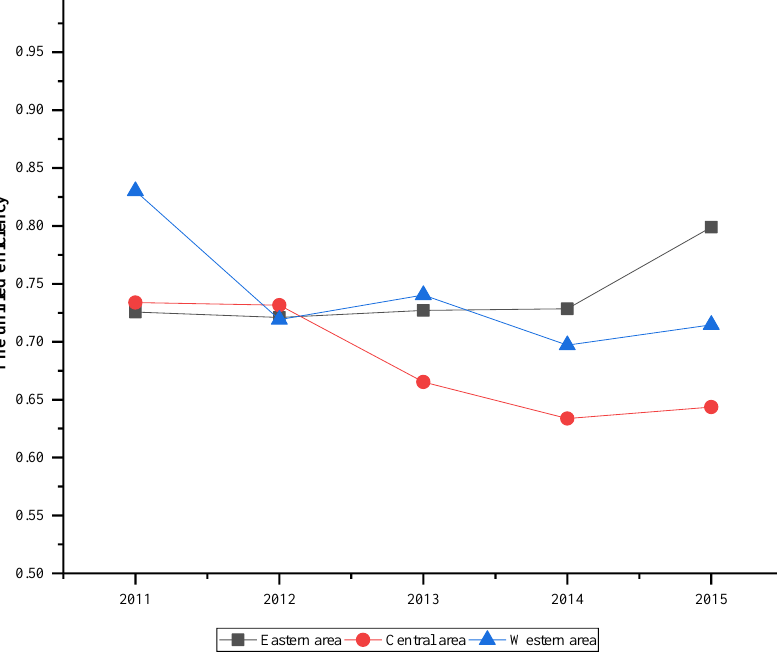
Figure 7. The unified efficiency of three areas.